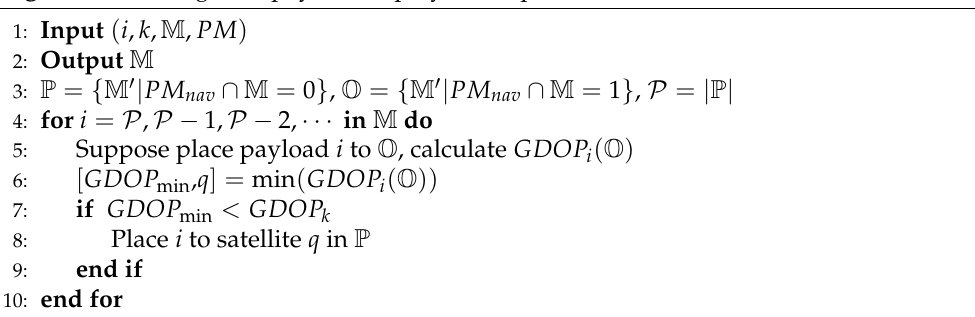
Algorithm 3 Navigation payload deployment